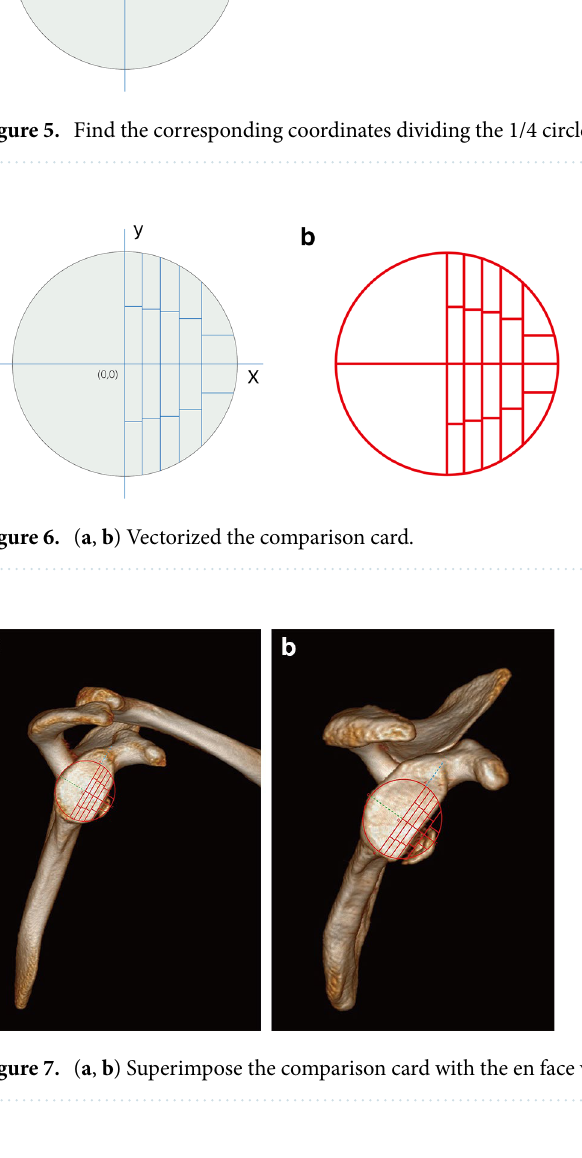
Re-mirror the 1/4 circle to obtain a complete circle (Fig. 6a). We used Adobe Illustrator (Adobe company) to vectorize the picture and remove the background to obtain the comparison card with a high pixel resolution (Fig. 6b).